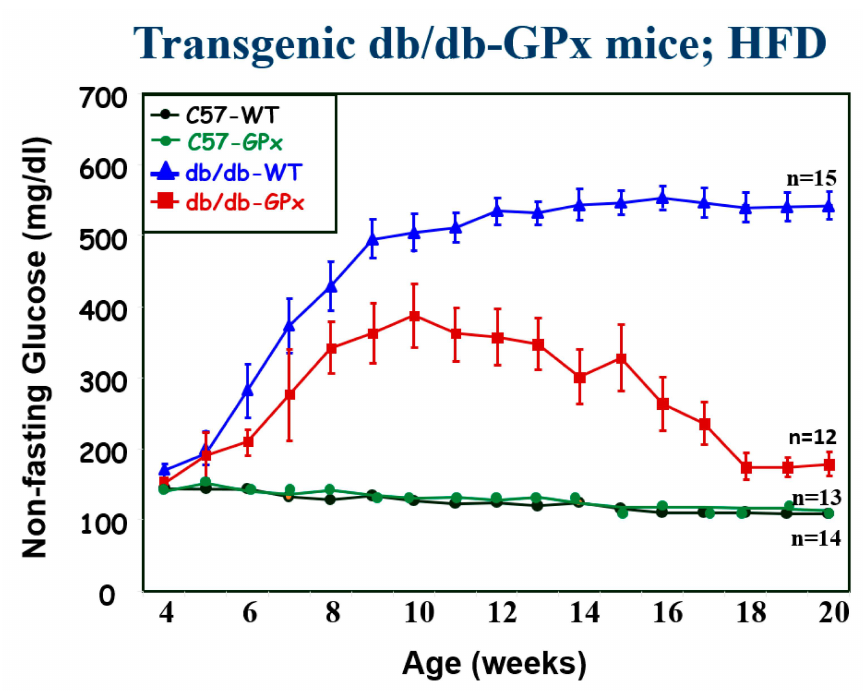
Figure 3. Beta cell-specific overexpression of glutathione peroxidase protects beta cells from the functional deterioration observed in wild-type db/db-GPx( − ) mice fed a high-fat diet. Initially, blood glucose levels began to rise in both the C57 wild type and the db / db transgenic animals. However, by 10 weeks glucose levels began to decrease to levels lower than those in the transgenic animals, and thereafter returned to the non-hyperglycemic range. We speculate that this delay in glucose response may have been related to the fact that the GPx transgene construct included a glucose-sensitive insulin promoter that was activated by the establishment of hyperglycemia. Modified from Ref. [21].